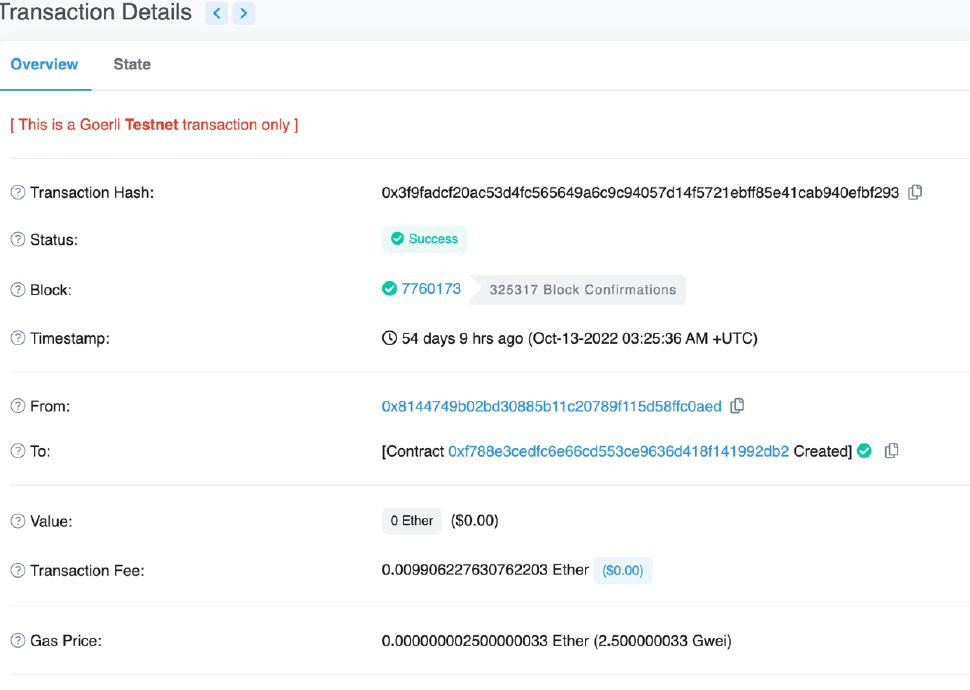
Figure A19. Proof of providing fund on Etherscan.